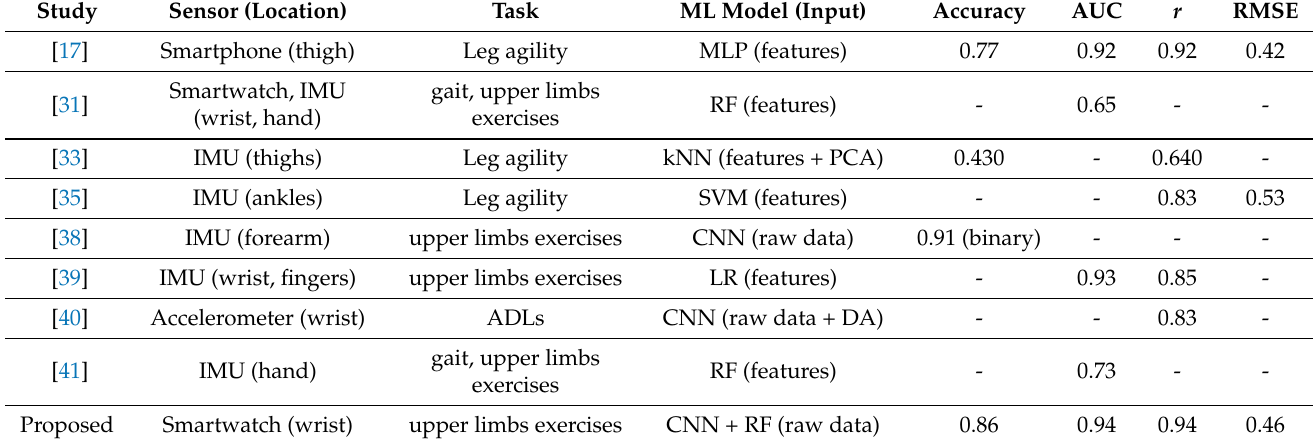
Table 5. Comparison of different bradykinesia detection methods and results. ML: machine learning; AUC: area under the curve; RMSE: root mean square error; IMU: inertial measurement unit; ADLs: activities of daily living; SVM: support vector machine; kNN: k-nearest neighbors; PCA: